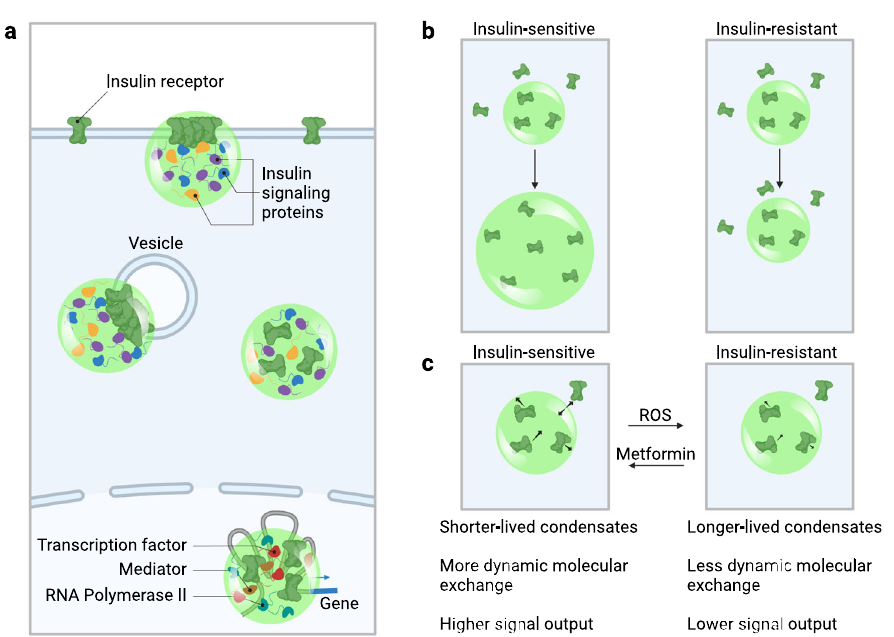
Fig. 6 | A proposed condensate model for insulin signaling and resistance. a Insulin receptor (green) is incorporated into condensates at the plasma mem- brane,atvesiclemembranes,inthecytosol,andinthenucleus,togetherwithother insulin signaling proteins and, in the nucleus, with proteins involved in transcrip- tion (Transcription factors, Mediator, RNA Polymerase II). b Insulin stimulation